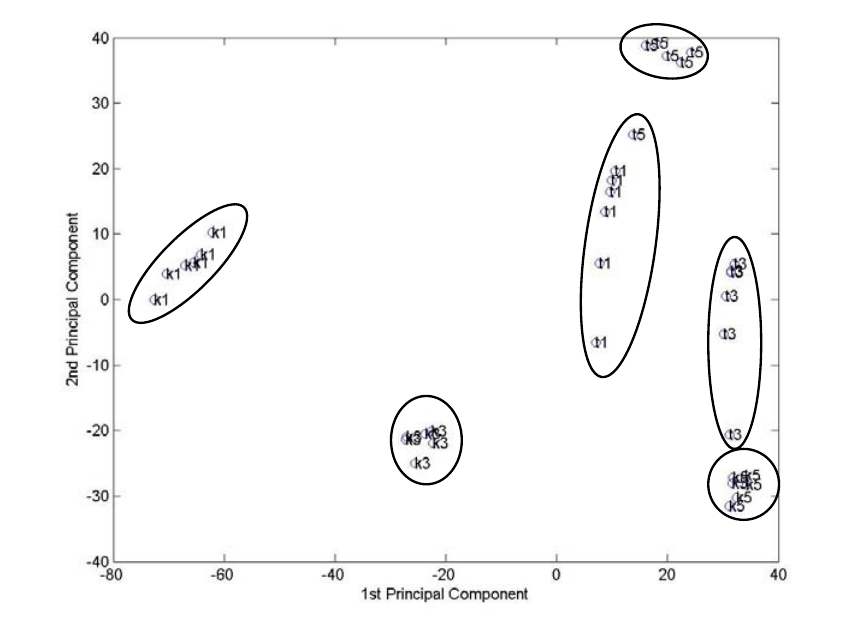
Figure 2. PCA score plot of the original anodic wave of copper electrode in six Chinese yellow wines mixed with 1 M NaOH solution. The potential range: -0.6 V to 0.4 V.